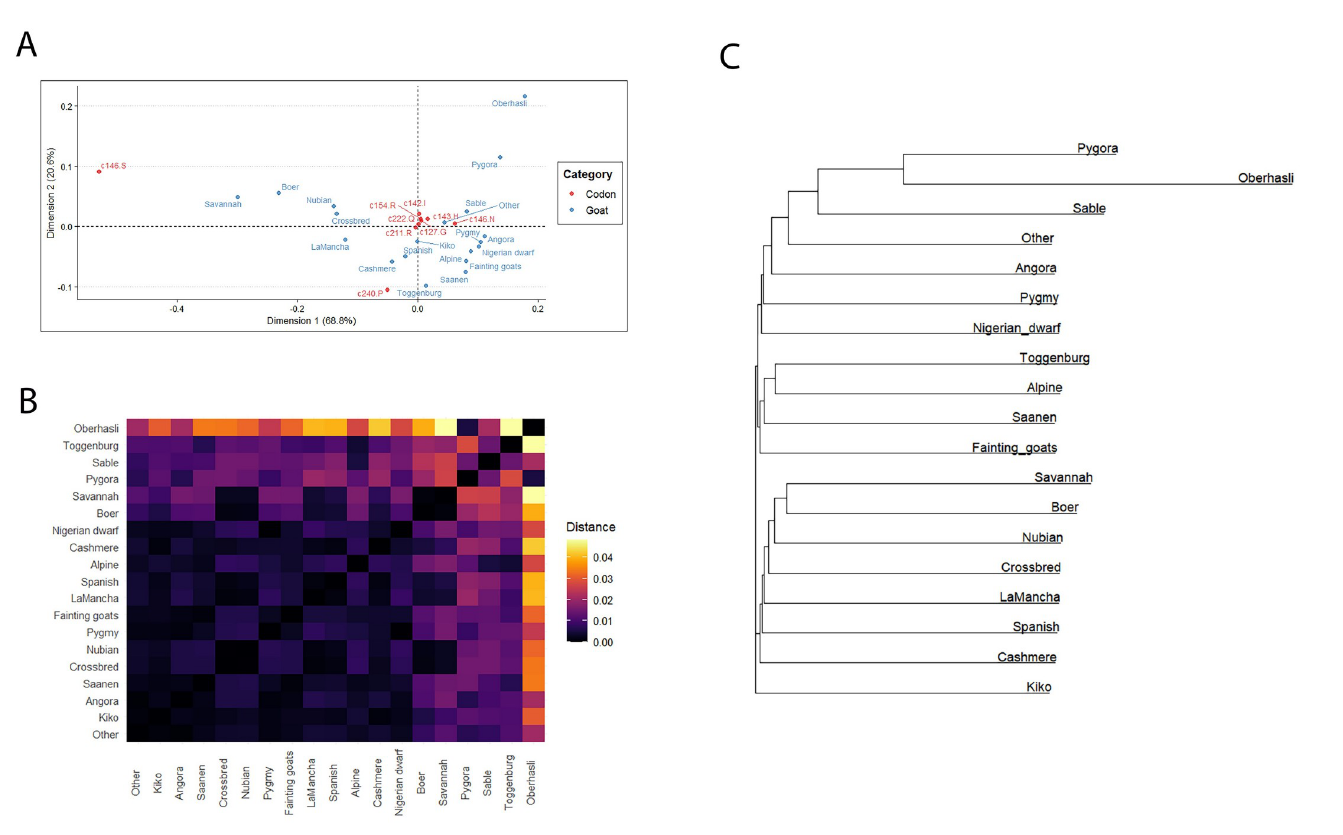
Fig 10. The effect of goat breeds on allelic presentations in the population at the given codon. (A) Correspondence analysis plot using the first two dimensions, by category (goat breed and codon). ( B) Heatmap displaying estimated Nei’s distance between breeds based on allele presence at codons 127, 142, 143, 146, 154, 211, 222, and 240. Rows and columns are sorted by average Nei distance from each other breed. (C) Neighbor-joining tree for goat breeds based on estimated Nei’s distance between breeds based on allele presence at codons 127, 142, 143, 146, 154, 211, 222, and 240.